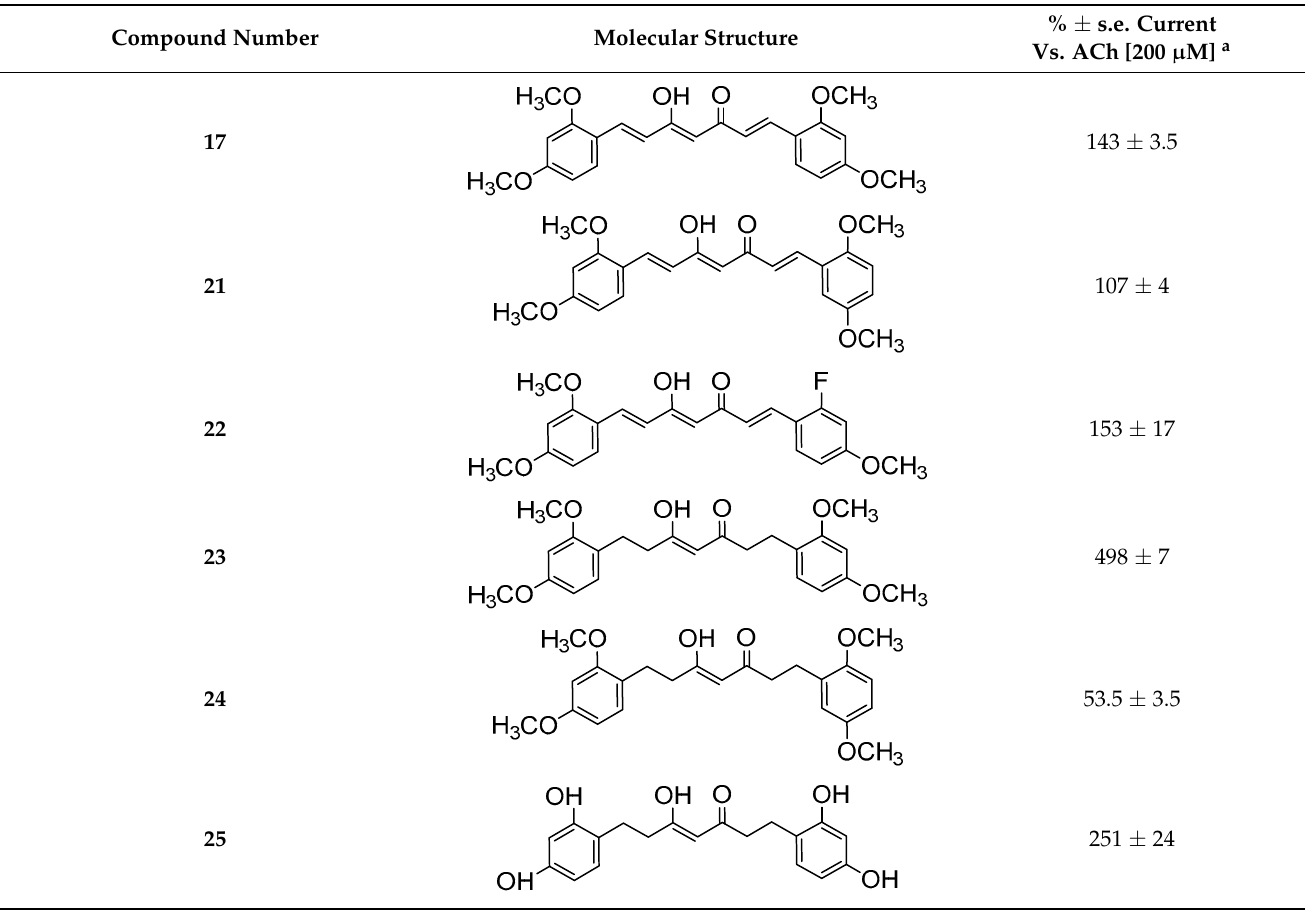
Table 2. Effects of compounds 17 and 21–25 on α 7 nAChR currents. Compound Num-